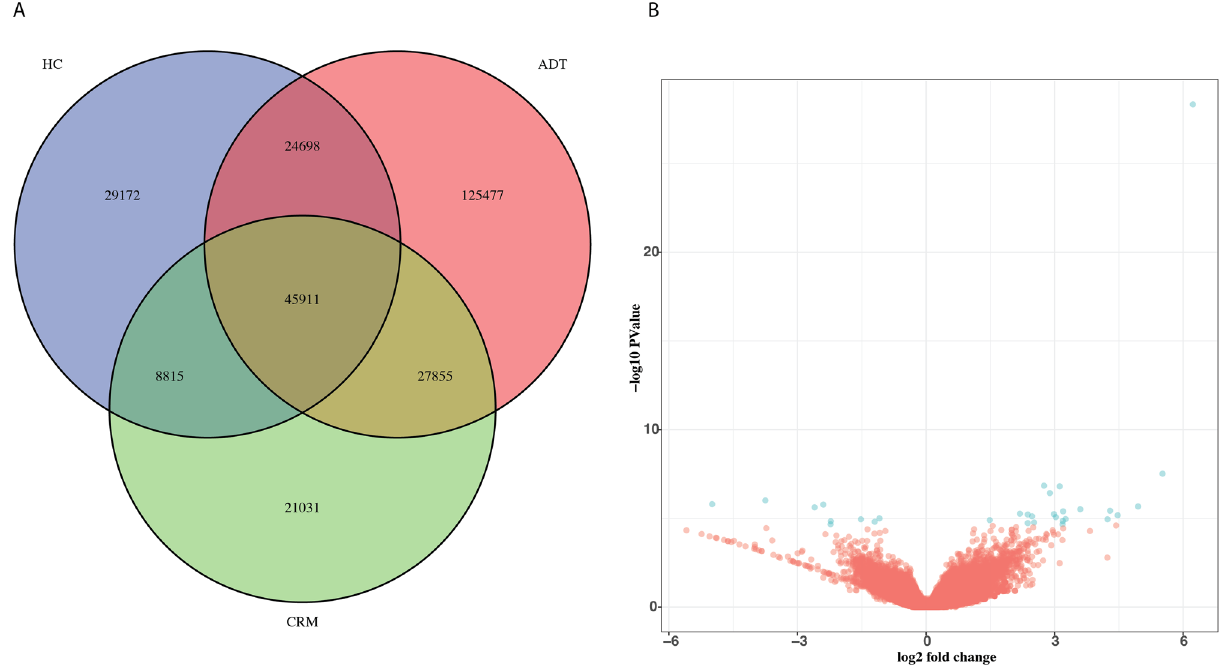
Figure 2. Chromatin re-arrangement occurs in the absence of three-dimensional changes. ( A ) Overlap between the group-consistent accessible peaks identified in HC, ADT and CRM samples. ( B ) Volcano plot showing the differences in CTCF binding affinity between 5 HC samples and 5 ADT samples. Blue dots represent sites whose log10(fold-change) was at least 1 and whose FDR was less than or equal to